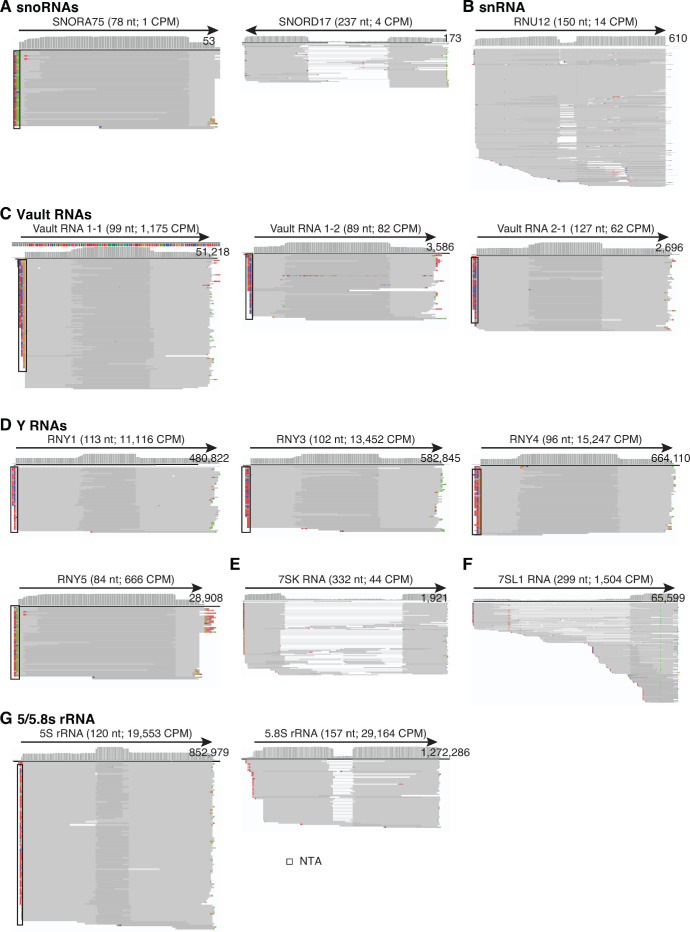
IGV screenshots showing examples of sncRNAs detected in combined datasets for DNase I-treated plasma RNA samples (n = 12).The name of the RNA is indicated at the top with the length (nt) and counts per million (CPM) for deduplicated reads shown in parentheses. The arrow below indicates the 5’ to 3’ orientation of the RNA. IGV coverage plots and alignments are labeled as described in Figure 1—figure supplement 3, with reads in the alignment down sampled to a maximum of 100. (A) The two most highly abundant snoRNAs (SNORA75 and SNORD17); (B) snRNA (RNU12); (C) Vault RNAs (Vault RNAs 1–1, 1–2, and 2–1); (D) Y RNAs (RNY1, RNY3, RNY4 and RNY5); (E) 7SK RNA; (F) 7SL RNA; and (G) 5S and 5.8S rRNA. In the read alignments, overlapping regions of paired-end reads are darker gray, and non-overlapping read pairs for RNAs > 150 nt (e.g., 7SK and SNORD17) are shown as gaps connected by thin blue lines. NTA/black boxes are non-templated nucleotides added during TGIRT-seq library preparation.